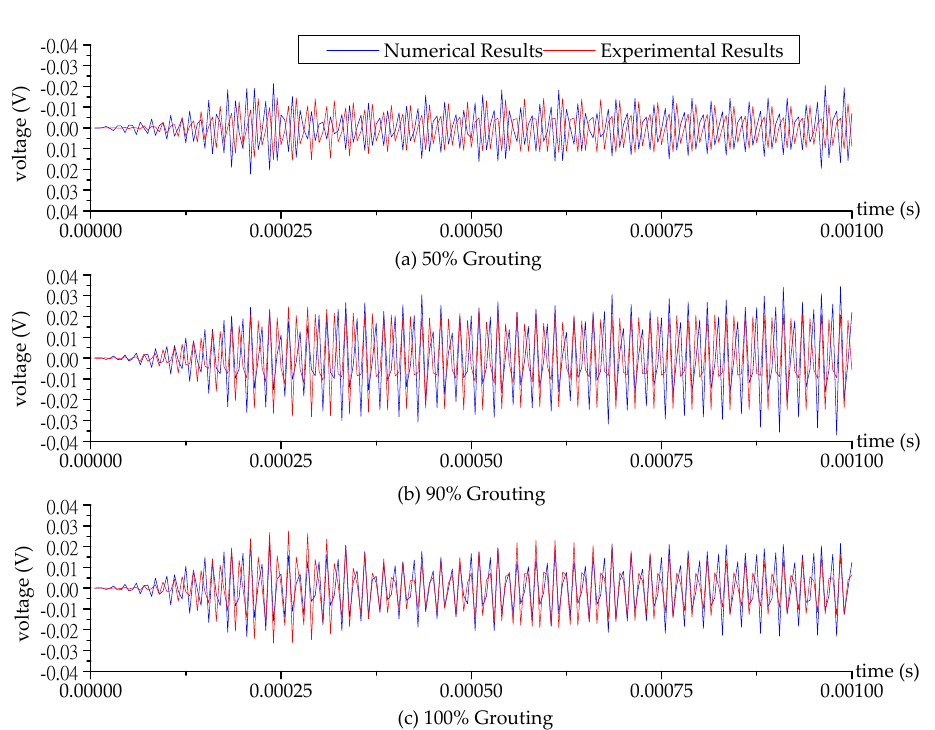
Figure 4. The experimental setup.